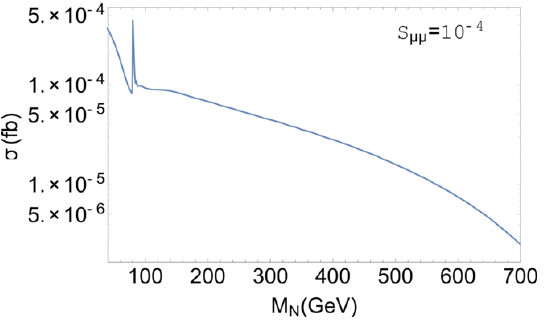
Figure 9 . Normalized distributions (cid:27) (cid:0) 1 d (cid:27)= d X for background channel e (cid:0) e + ! W + W + W (cid:0) W (cid:0) ! (cid:22) (cid:6) (cid:22) (cid:6) (cid:23)(cid:23) + 4 j at the 1 TeV ILC for the missing transverse momentum =p momentum =p and missing total energy =E . The missing total energy is the c.m. energy 1000 GeV L minus the sum of energies of all visible particles in the (cid:12)nal state.